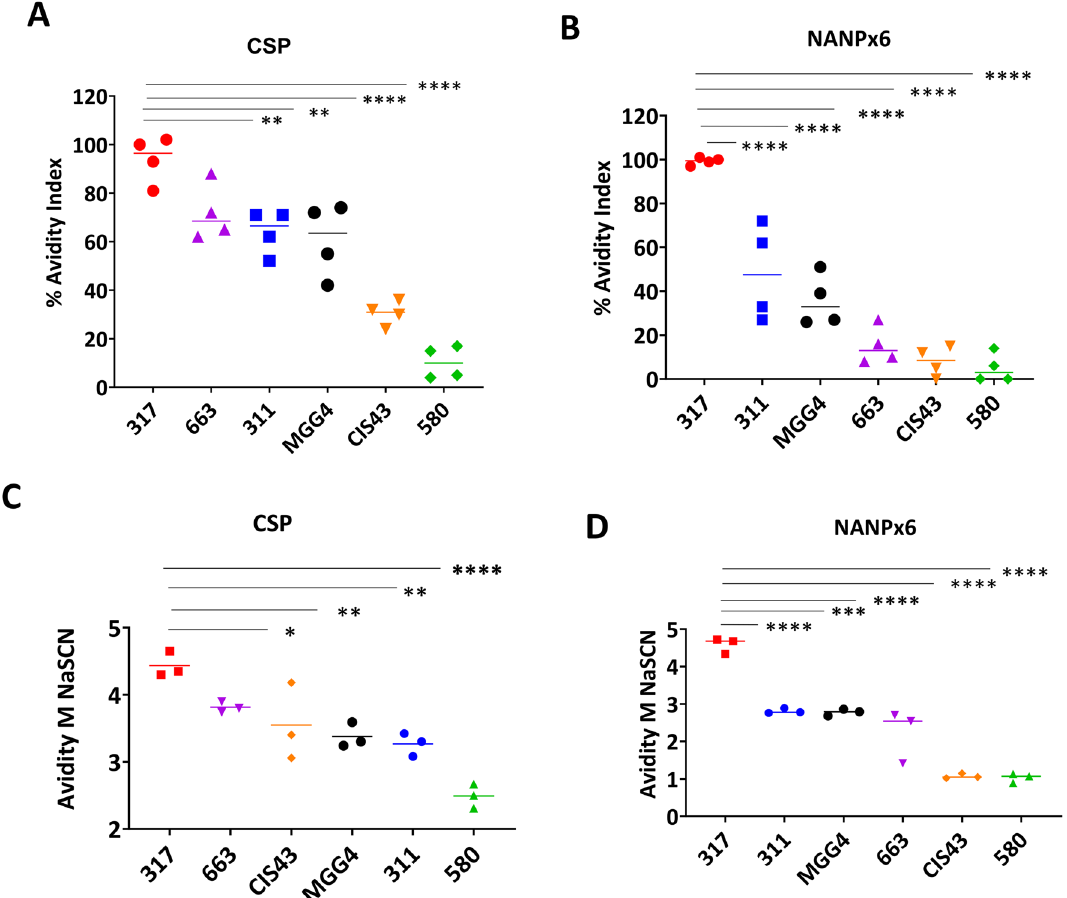
Figure 5. Avidity index (AI). AI for the CSP mAbs determined using 2 M Sodium Thiocyanate (NaSCN) wash method against ( A ) FL-CSP antigen or ( B ) NANPx6 antigen. Avidity was also determined using washing with a serial dilution of NaSCN against ( C ) FL-CSP antigen or ( D ) NANPx6 plate antigen. Mean data and individual values from three or more independent experiments arranged from highest to lowest. Comparisons against mAb 317; (*) indicate level of significance for mean differences estimated by ANOVA and p values corrected for multiple comparisons by Tukey’s 317 showed the second-best inhibition at 0.5 and 0.25 µg/ml concentrations, but at the lowest 0.05 µg/ml dose mAb MGG4 inhibited better than mAbs 317, 580 and 311 (Table S6; Fig. 6C, p values < 0.05). The mAb dose response data (Fig. 6D) was fitted to a three-parameter Michaelis–Menten dose response model (Fig. 6E), allowing the estimation of mAb dose required for 80% inhibition (ID 80 ) (Table S7; Fig. 6F). The ID 80 value of the top performing mAb CIS43 (ID 80 = 0.04 µg/ml; CI -0.26 to 0.33) was fivefold lower than mAb 317 (0.19 µg/ml; CI -0.1 to 0.48), although this ID 80 difference was not statistically significant (Table S7). ID 80 for mAb 580 showed it was 50 times less inhibitory than mAb CIS43 and 10 times less inhibitory than mAb 317 ( p < 0.01). In vivo protection. Intravenous transfer of mAbs in C57BL/6 mice was followed by challenge with 1000 transgenic P. berghei sporozoites, expressing P. falciparum CSP, via the intravenous route 40 . The absence of blood stage parasites over the next 14 days indicated sterile protection. To discern differences between mAbs, contin- gency table analyses were performed by Fisher’s exact test and Kaplan-Meir survival curves were compared by a Log-rank test. Experiment 1: 100 µg of each mAb was transferred and the mice were challenged at 24 h (n = 5) or 48 h (n = 5) post transfer (Fig. 7A, B). At 24 h, mAb 317 protected 100% mice compared to 0% of controls. MAbs 311 and 663 protected 60% mice and mAb CIS43 protected 40%. Fisher’s test showed higher frequency of protected mice for mAb 317 compared to the controls, mAb 580 and mAb MGG4 group ( p values = 0.004) (Fig. 7A; Table S8). The five remaining mice were challenged at 48 h and mAb 317 showed 80% protection. MAb CIS43 protected 40% mice which was also consistent with the 24 h challenge. Unlike 0% and 30% protection for mAbs MGG4 and 311 in the 24 h challenge respectively, 60% and 80% protection were observed at 48 h challenge. The higher protection was likely due to the low mouse numbers (n = 5) and reduced sporozoite infectivity at 48 h challenge time-point. Fisher’s test on protection frequency for mAbs 311 and 317 groups showed significantly higher protection than the controls and mAb 580 ( p values = 0.024). Log-rank test confirmed these inferences (Fig. 7B; Table S8).